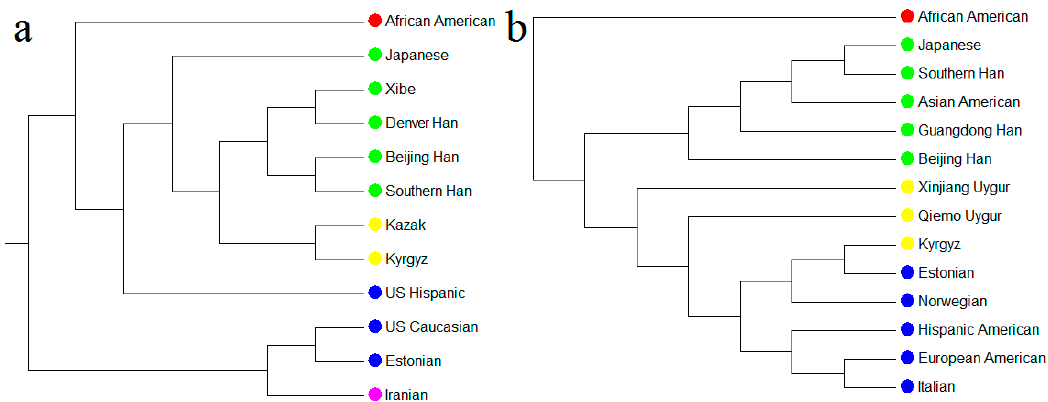
Figure 4. The neighbor-joining (NJ) trees for the Kyrgyz group and reference populations, ( a ) based on the same of 58 mtDNA SNPs; ( b ) based on the same of 23 Y-STRs.